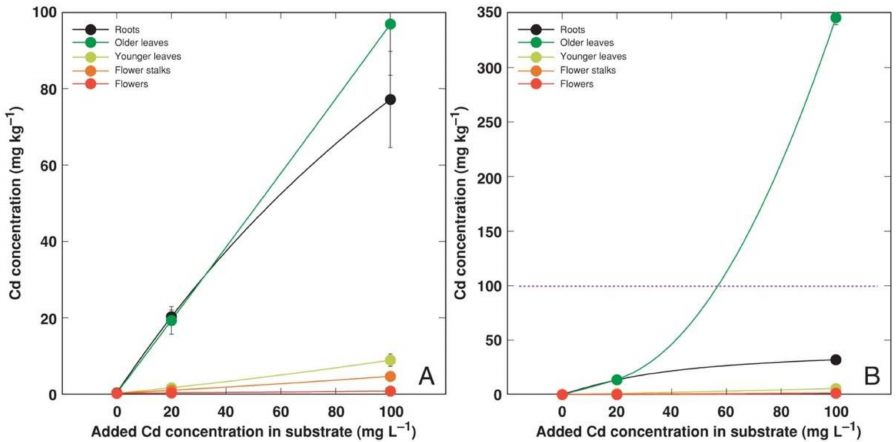
Figure 4. Effect of added Cd concentration in soil on Cd concentration in different parts of Armeria maritima plants of accession AM1 ( A ) and AM2 ( B ) after cultivation for 9 weeks. Data are means ± SE from 3 samples. Dotted line indicates accepted hyperaccumulation threshold level for the respective metal.